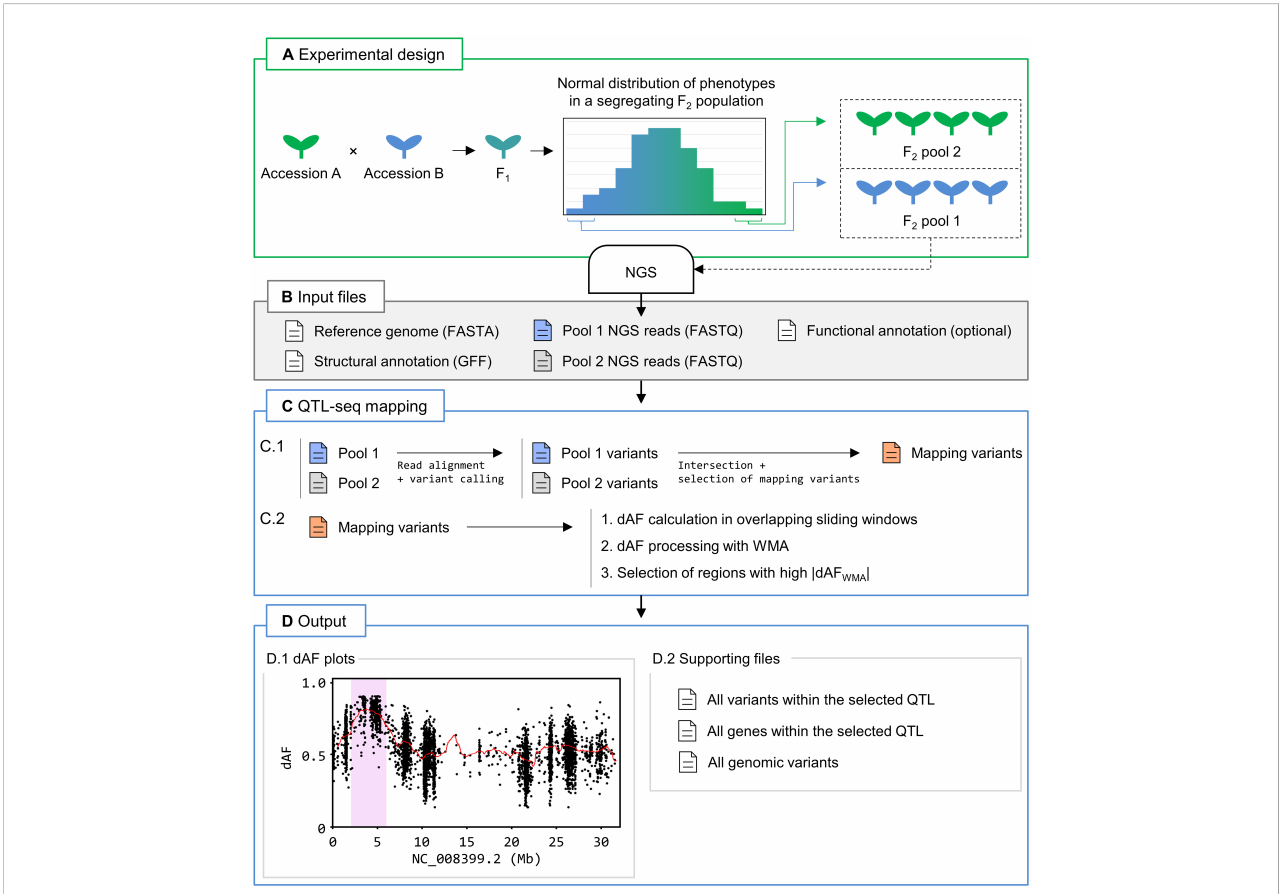
FIGURE 2 QTL-seq mapping with Easymap v.2. (A) Overview of the experimental design. Two wild-type accessions that genetically differ for a quantitative trait of interest (in blue and green) are crossed. The F 1 progeny is selfed to generate a segregating F 2 population. Plants exhibiting the most extreme phenotypes for the trait of interest are bulked into two pools for DNA extraction and NGS. (B) Input fi les for Easymap v.2. Files containing the reference genome sequence and the NGS reads from both pools mentioned above are required. Structural and functional annotation fi les are optional. (C) Easymap v.2 QTL-seq mapping work fl ow. Files are color-coded in blue, green and red for pools 1 and 2, and mapping variants, respectively. The arrows represent steps performed with third party software (alignment and variant-calling) and proprietary Python scripts (all remaining steps). (C.1) Reads from pools 1 and 2 are processed to generate variant fi les, which are intersected. Segregating variants that are present and have an allele frequency lower than 1 in both samples are then selected to create a list of mapping variants. This step fi lters out variants common to both parental lines but different to the reference genome. (C.2) The difference between the allele frequency values of the mapping variants of the two samples (dAF) are calculated. dAF values per window are then averaged with the values of adjacent windows via weighted moving averages (WMA) to smooth out the mapping signal, generating dAF WMA values. Finally, the processed dAF WMA values are searched for regions with nonzero values to select those positively or negatively in fl uenced by phenotypic selection. (D) Easymap v.2 output from a QTL-seq mapping experiment in rice (Takagi et al., 2013). (D.1) dAF plotted along a chromosome containing a candidate QTL, highlighted in pink. The mapping variants are represented by black dots. Processed dAF WMA values are represented by a red line. These plots are generated for each chromosome. (D.2) Supporting fi les are provided to assess the results of mapping analysis and to establish alternative or additional regions of interest. Diagrams of the candidate genes and tables including the candidate variants and genes are reported when a GFF fi le is